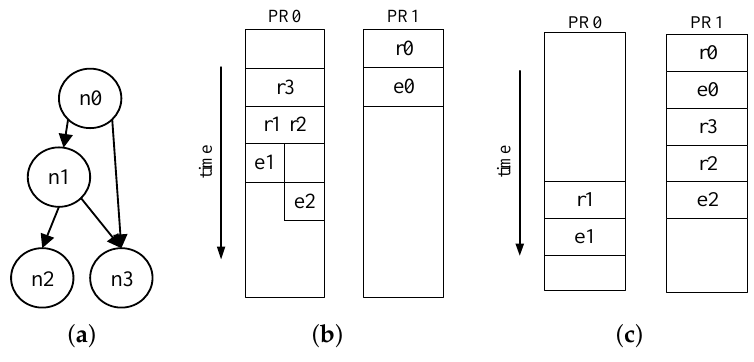
Figure 6. Infeasible